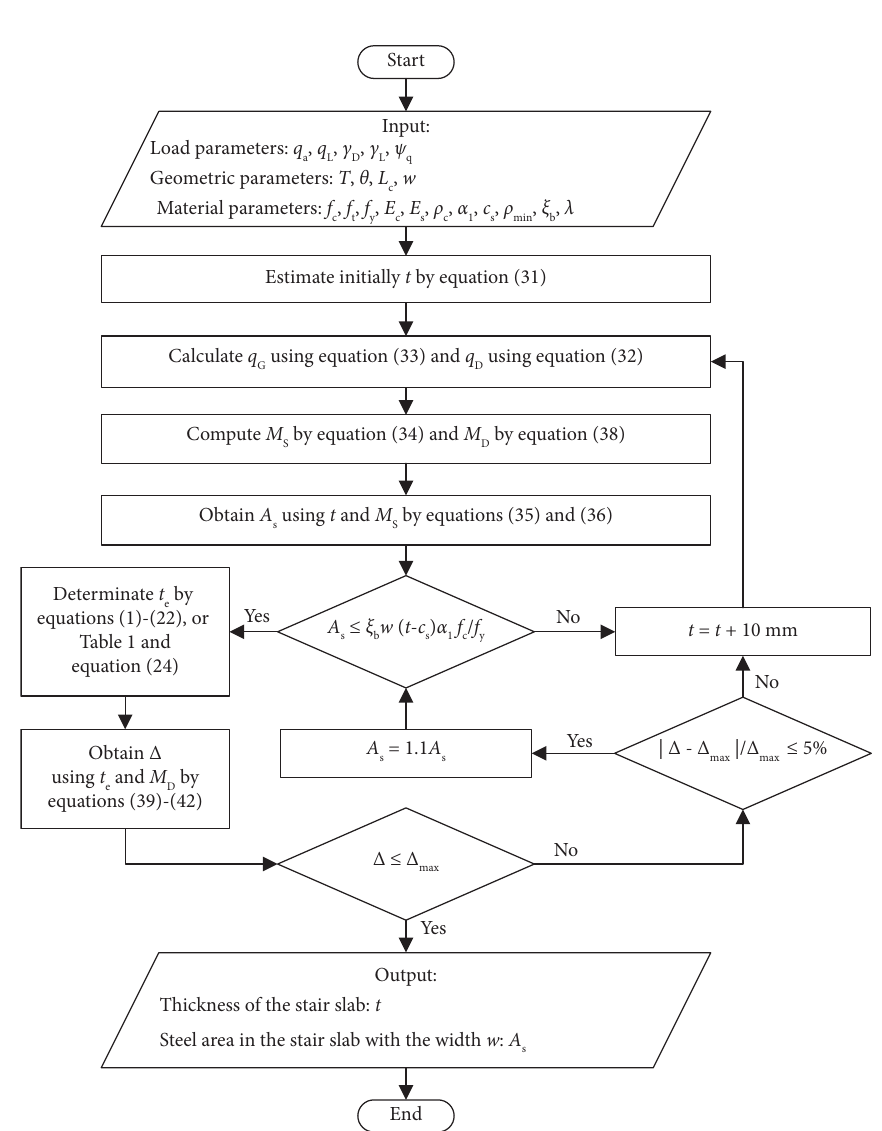
Figure 9: Te fow chart of the design method considering step stifness for RC stair slabs based on the Chinese codes [28,